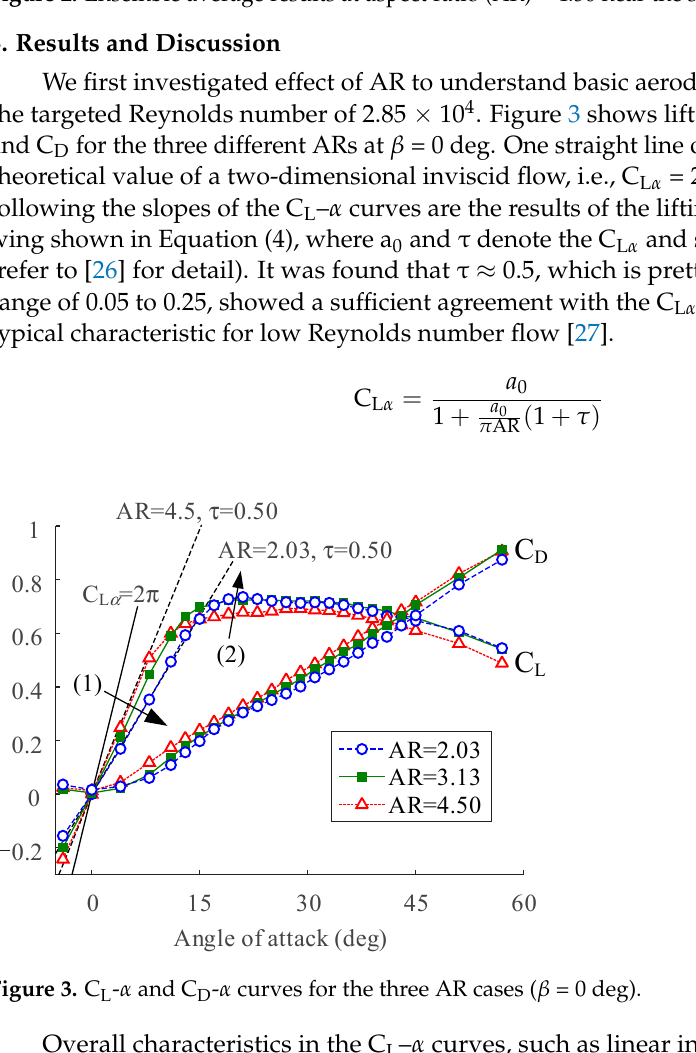
( c ) Figure 4. C L – α and C D – α curves with respect to β . ( a ) AR = 2.03; ( b ) AR = 3.13; ( c ) AR = 4.50.